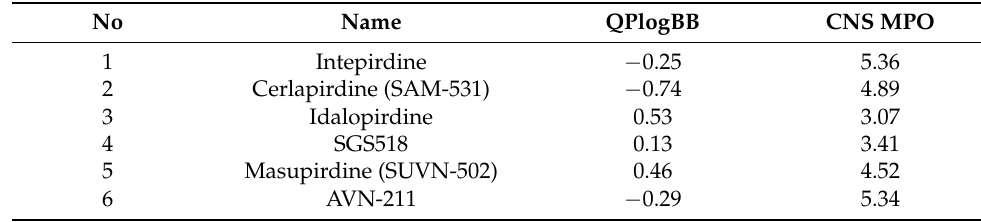
Table 4. List of literature compounds for 5HT6 receptor, with their calculated QPlogBB and CNS MPO